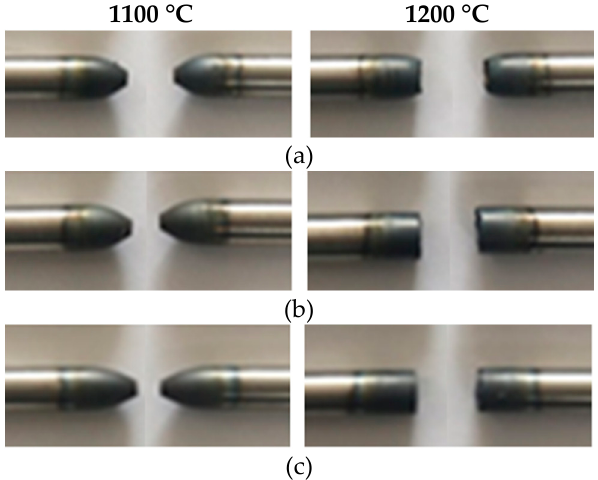
Figure 6. Fractured shapes of the tensile test specimens at 1100 and 1200 °C: ( a ) 0.1 s − 1 strain rate, ( b ) 10 s − 1 strain rate, ( c ) 30 s − 1 strain rate.